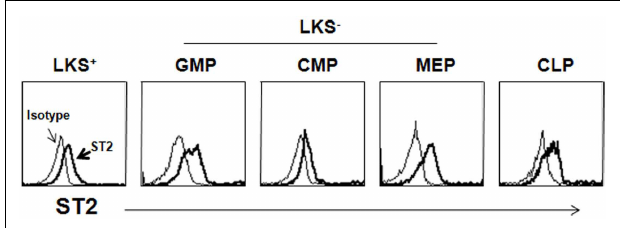
FIGURE 1 | Expression of ST2 on HSPCs . Lineage marker-negative cells were enriched from BM suspension before staining with antibodies to hematopoietic subsets and ST2.The open histogram depicts staining with the isotype-matched Ab. LKS + , lin − c-Kit + Sca-1 + ; LKS − , lin − c-Kit + Sca-1 − ; GMP, granulocyte-monocyte progenitor; CMP, common monocyte progenitor; MEP, megakaryocyte-erythrocyte progenitor; CMP, common lymphoid